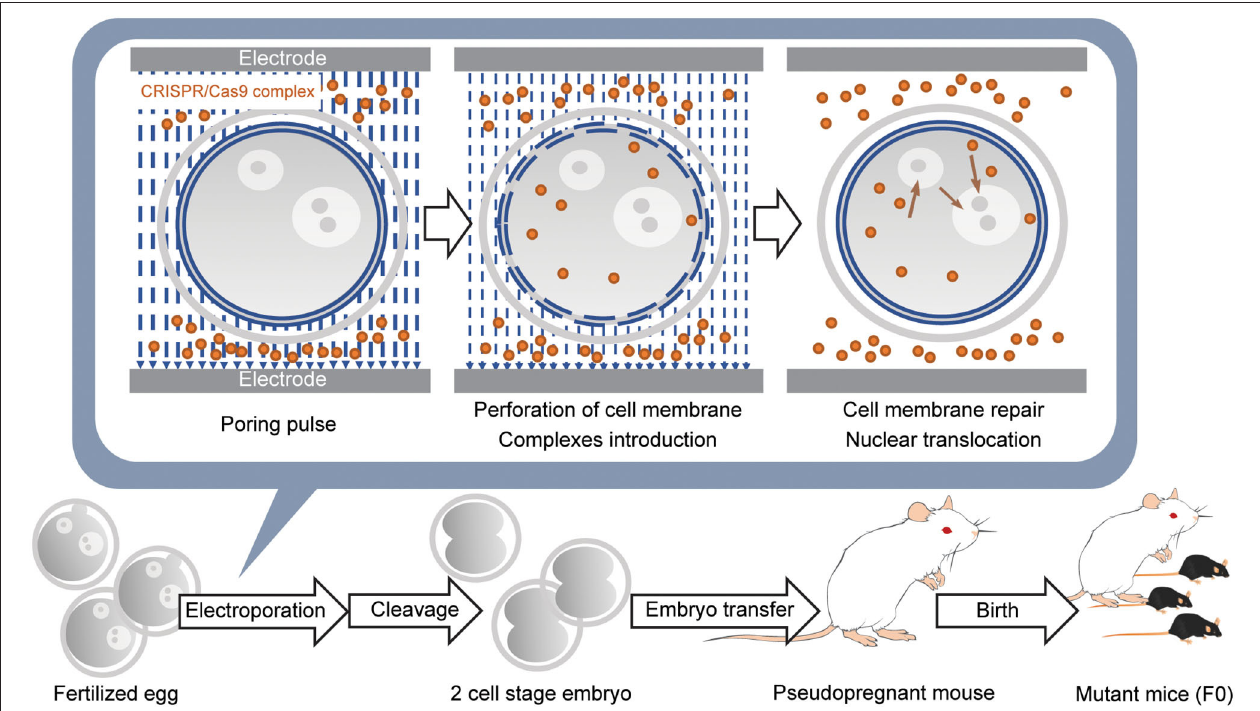
FIGURE 3 | Introduction of CRISPR/Cas9 complex into fertilized eggs by electroporation and generation of the gene-modified mouse. Fertilized eggs are placed in an electroporation buffer containing CRISPR/Cas9 complex filled inside a customized electrode and pulsed to generate perforation of the cell membrane. DNA donors are also included when generating knockin mice. Further pulses lead to the introduction of CRISPR/Cas9 complex into the cytoplasm. When the pulsing is stopped, the cell membrane is repaired. Subsequently, the remaining CRISPR/Cas9 complex in the cytoplasm is translocated into the nucleus. Embryos developed at the 2-cell stage the next day are transferred into the oviducts of the pseudopregnant female mouse, and 18–20 days later, F0 mice are